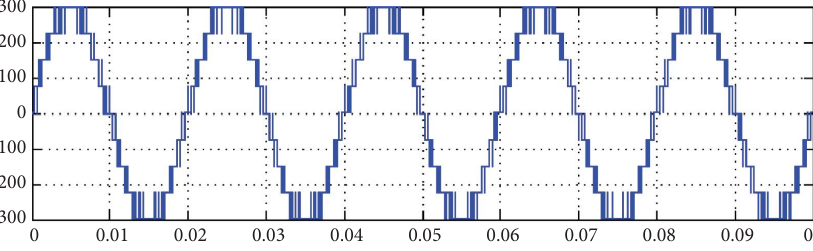
Figure 16: Output voltage for 9-level inverter.